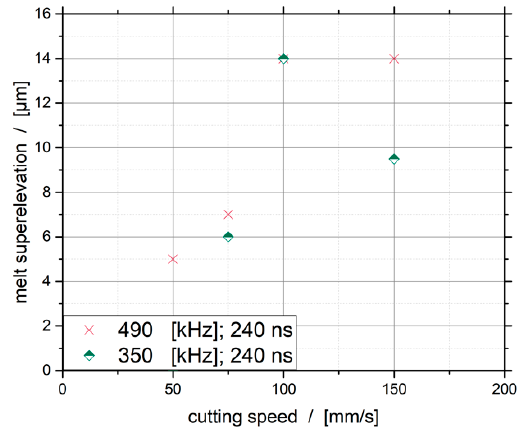
Figure 8. Influence of the cutting speed on the melt superelevation.